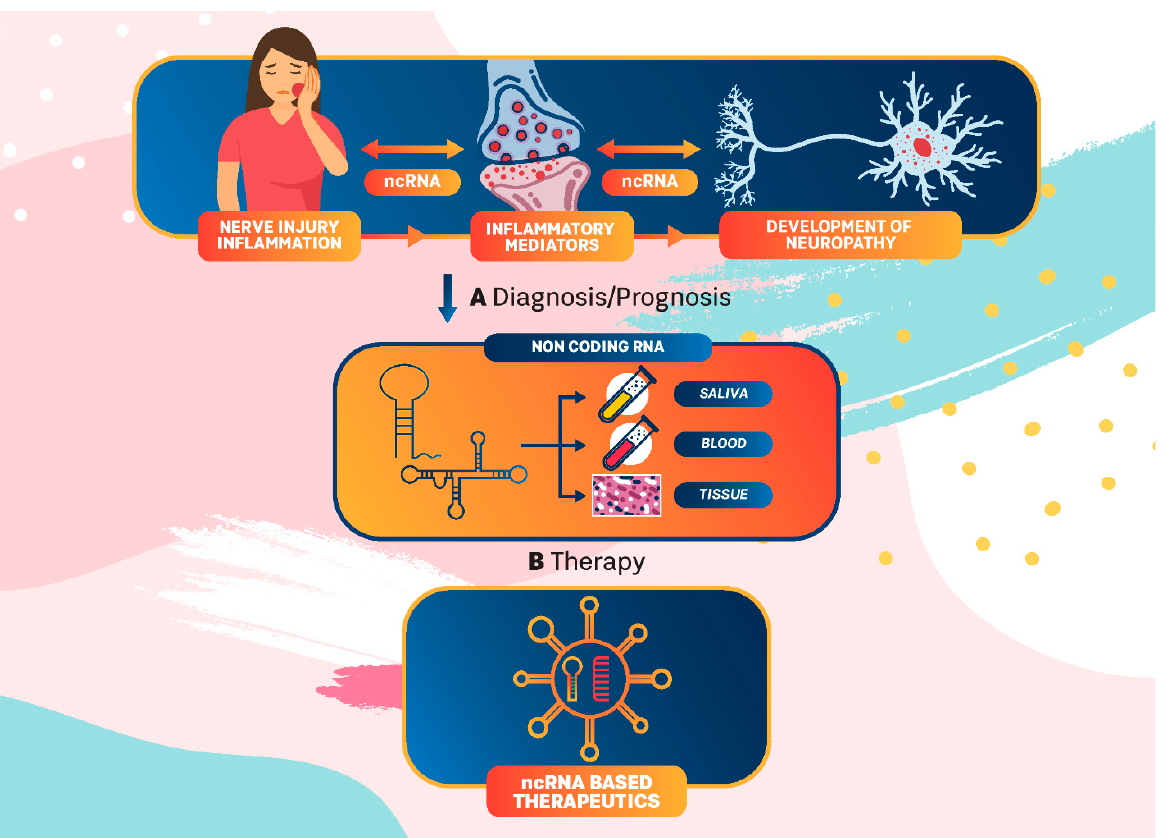
Figure 3. ncRNA in precision medicine for orofacial neuropathic pain. ncRNA interplay between injury/inflammation and neuropathy development could be used in diagnosis/prediction and in patient-tailored treatments as an integral part of precision medicine for neuropathic pain.